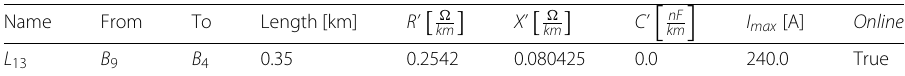
Table 4 Example of a branch description